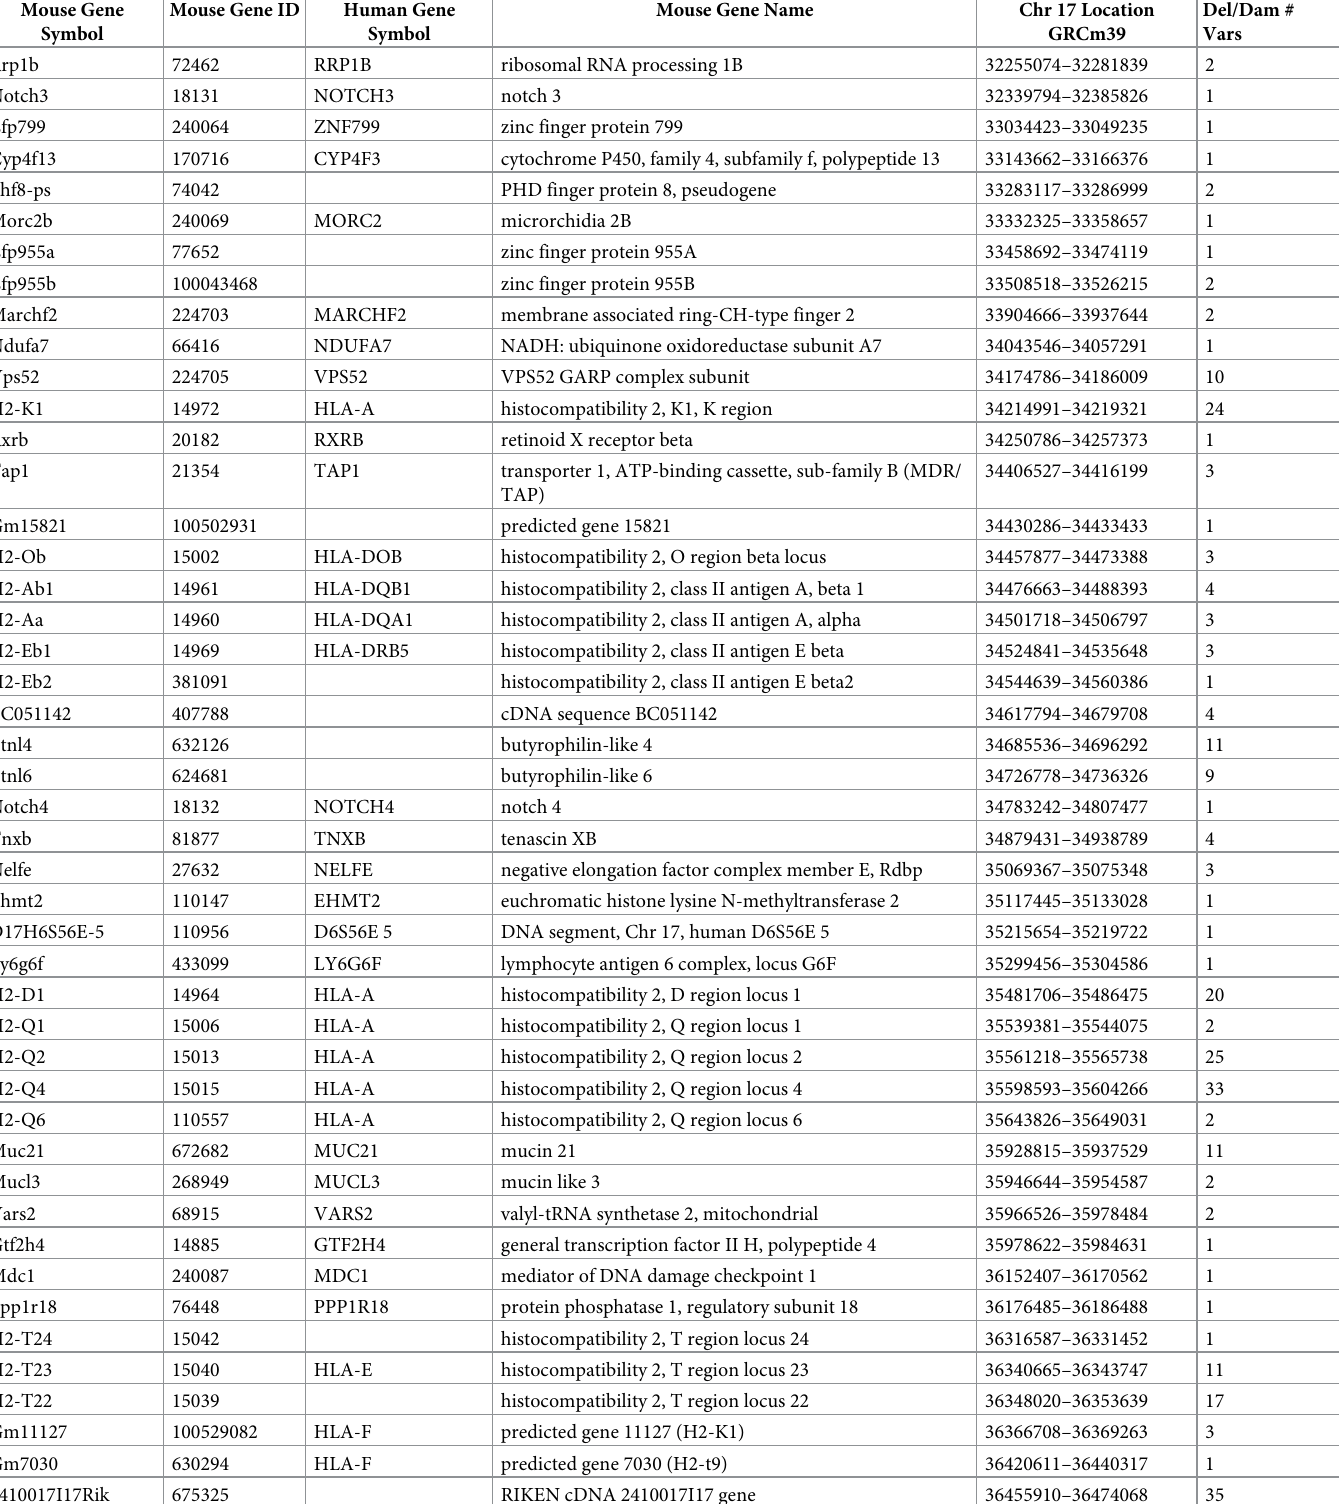
Table 5. Protein coding genes in the Chr17 QTL of G59S-hDCTN1 mice demonstrating non-synonymous variations deemed to be deleterious and/or damaging. Mouse Gene